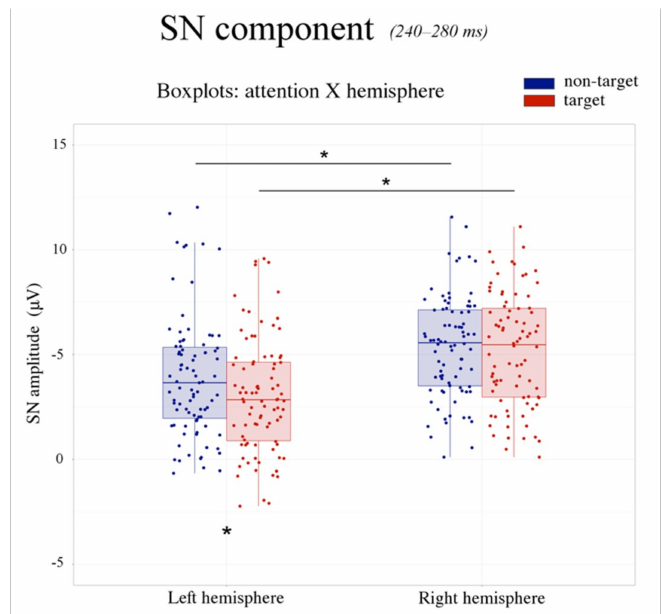
Figure 6. SN component: boxplots. The figure illustrates the boxplots relative to the significant attention by hemisphere interaction for the SN component. The SN was larger over the left than the right hemisphere. Moreover, the SN was more negative in response to the target (in red) compared with non-target (in blue) stimuli over the left, but not the right hemisphere. This evidence suggests that selective attention processes for visual object recognition are